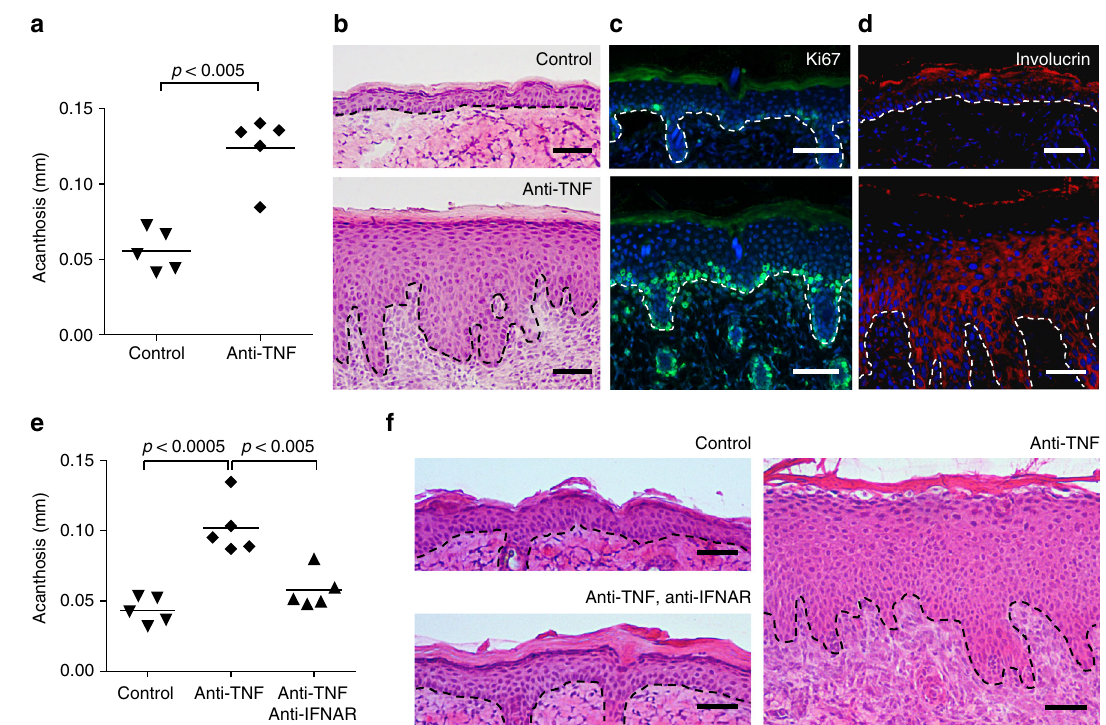
Fig. 5 Type I interferon-dependent psoriasis-like skin phenotype induced by anti-TNF. a Quanti fi cation of epidermal thickening (acanthosis) in mice treated with or without anti-TNF antibody 7 days after mechanical injury by tape stripping. Representative HE staining ( b ), immuno fl uorescence staining for Ki-67 (proliferation, c ), and involucrin (differentiation, d ) for both untreated and anti-TNF-treated mice 7 days after mechanical injury. e Quanti fi cation of acanthosis 7 days after mechanical injury of mice treated with or without anti-TNF, and with or without anti-IFNAR antibodies. f Representative HE staining of skin 7 days after mechanical injury of untreated mice and mice treated with anti-TNF antibody alone or anti-TNF and anti-IFNAR antibodies combined. Experiment depicted is representative for at least three independent experiments. Scale bars represent 50 μ m. Dashed line b – d and f represents border between epidermis above and dermis below. All statistical analyses were performed with unpaired Student ’ s t -test. Anti-IFNAR = anti-type I interferon receptor anti-TNF (Fig. 6a, b). Because unconventional T cells such as γ / δ - T cells have been implicated in the development of psoriasiform skin in fl ammation in mouse models 47 , we treated Rag2 − / − mice, which are de fi cient of both conventional α / β -T cells and γ / δ - T cells, with anti-TNF. Similar to wild-type mice, anti-TNF- − / − treated Rag2 mice developed a psoriatic phenotype with sig- ni fi cantly increased epidermal thickness (Fig. 6a, c). These data indicate that neither conventional T cells nor γ / δ -T cells are